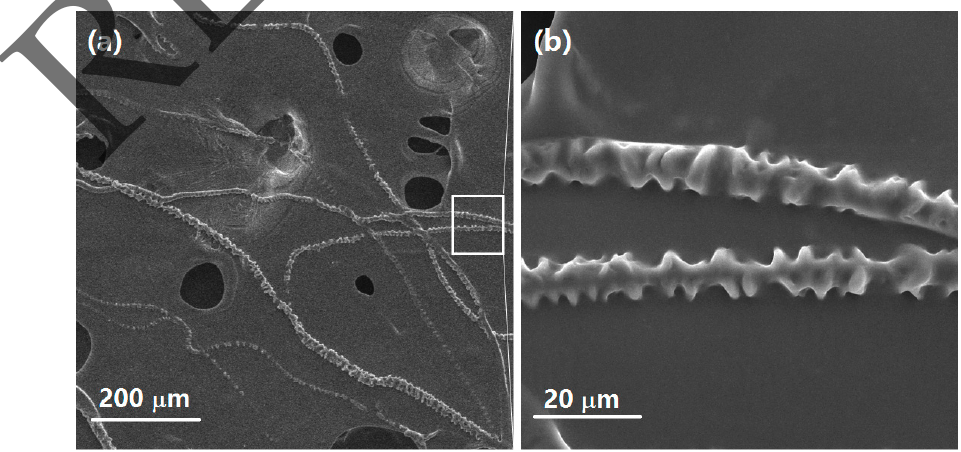
Figure 2. The morphology of micro-sized ERFs produced using 1% ENR polymer concentration.